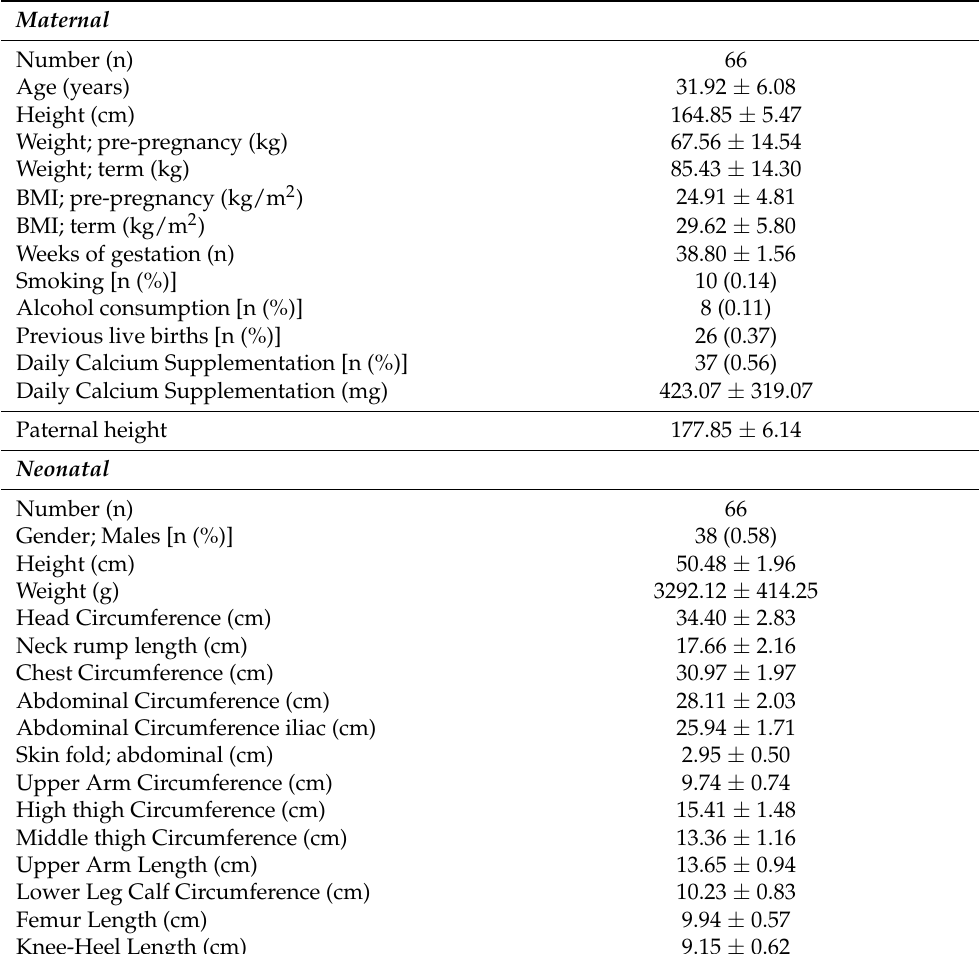
Table 1. Maternal and neonatal demographic and anthropometric characteristics.